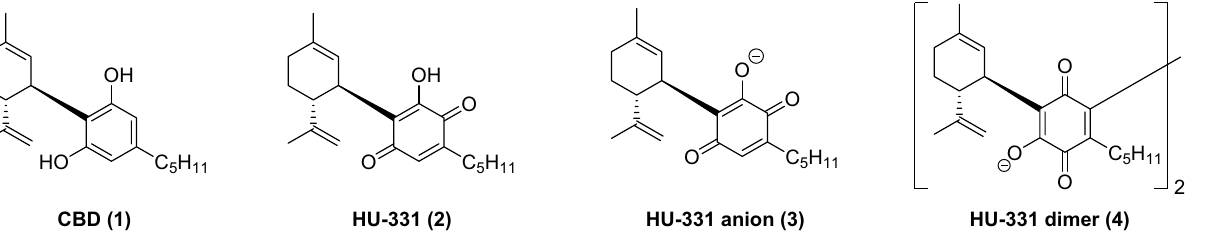
Figure 1. Structures of cannabidiol (CBD) and its formed degradants in the Beam test. CBD ( 1 ), HU-331 ( 2 ), HU-331 anion ( 3 ) and HU-331 anion dimer ( 4